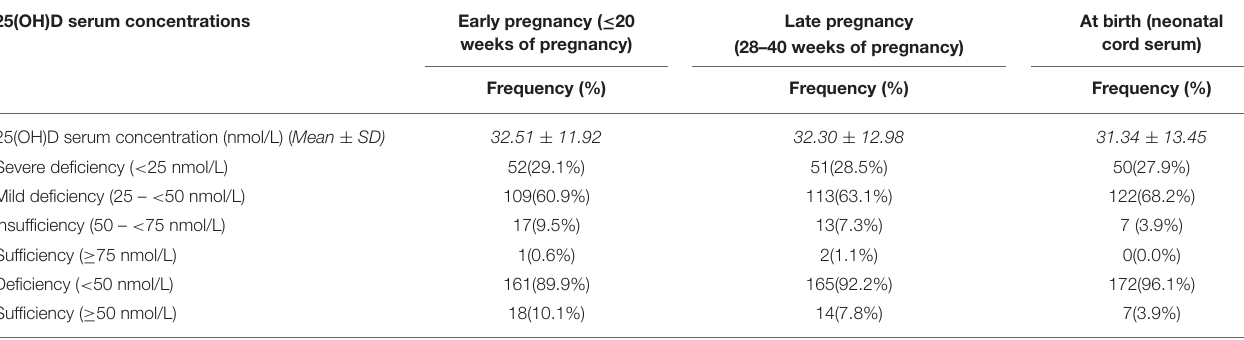
TABLE 3 | Vitamin D status in early and late pregnancy and neonatal cord serum ( n = 179).